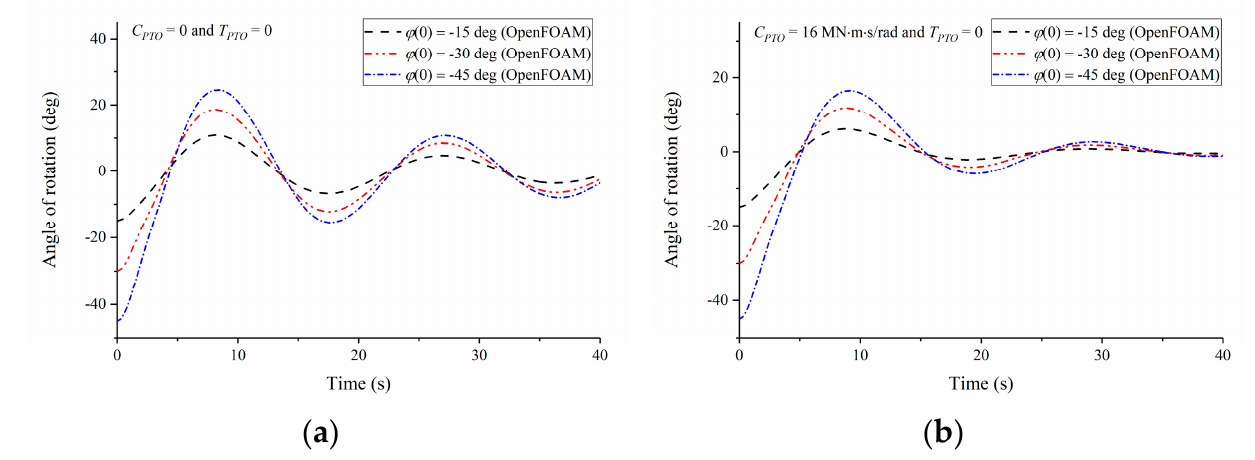
Figure 12. The time–history free decay response based on CFD for three distinct initial angles of a no-friction flap ( T PTO = 0) with different PTO damping: ( a ) C PTO = 0; ( b ) C PTO = 16 MN · m · s/rad.